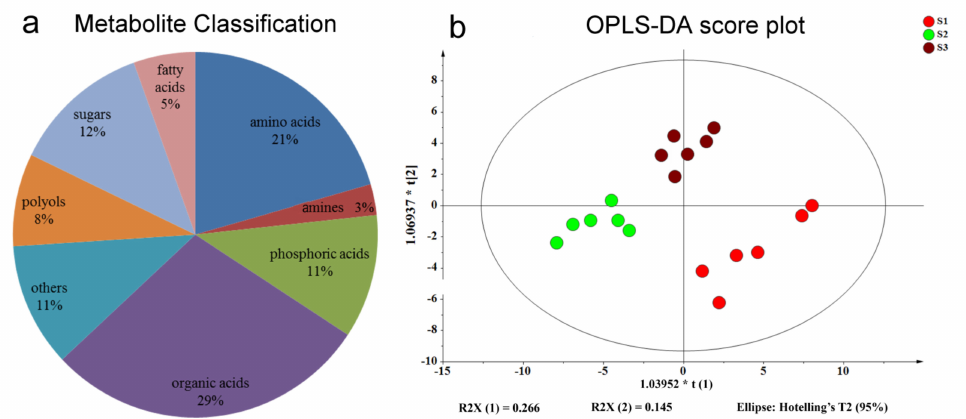
Figure 1. Pie chart of metabolite classification ( a ) and OPLS-DA score plots for metabolic profiling analysis ( b ). The score of variation explained by each principal component is indicated on the axes. Each point corresponds to a plant sample, and different colors indicate the different treatments. R2X-1 and R2X-2 are the degrees of explanation on the first and second principal component axes, respec- tively; t-1 and t-2 are the first and second principal component axes, respectively. Ellipses represent the 95% confidence regions for each subclass of observations, assuming normal